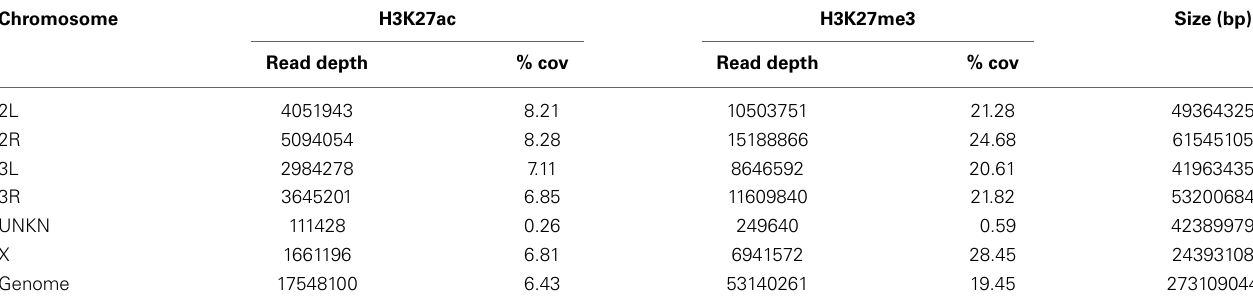
Table 2 | Coverage of H3K27ac and H3K27me in the A. gambiae genome by chromosome. Chromosome